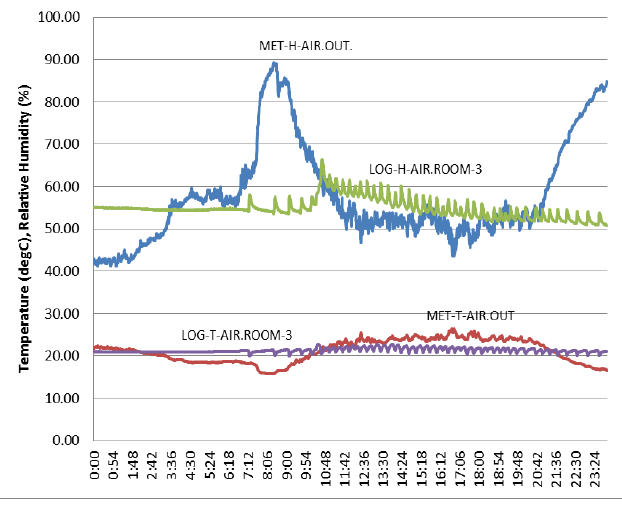
Fig. 11. Indoor and outdoor temperature and humidity changes.